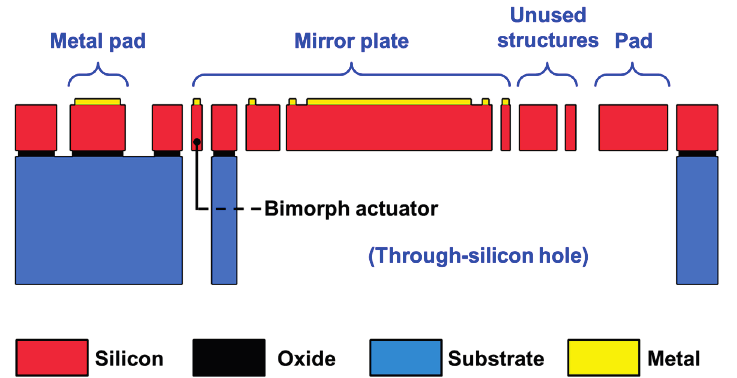
Figure 3. Schematic cross-section view along A–A’ of Figure 2c. The structure details are depicted and the materials used are